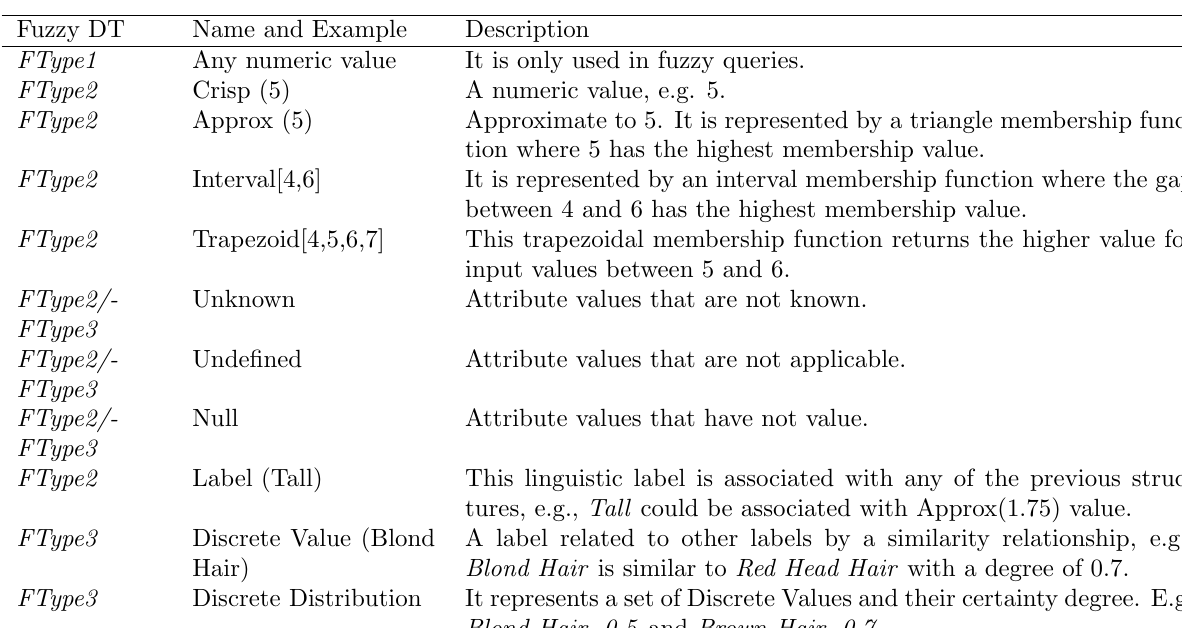
Table 1. Fuzzy Basic data types defined in